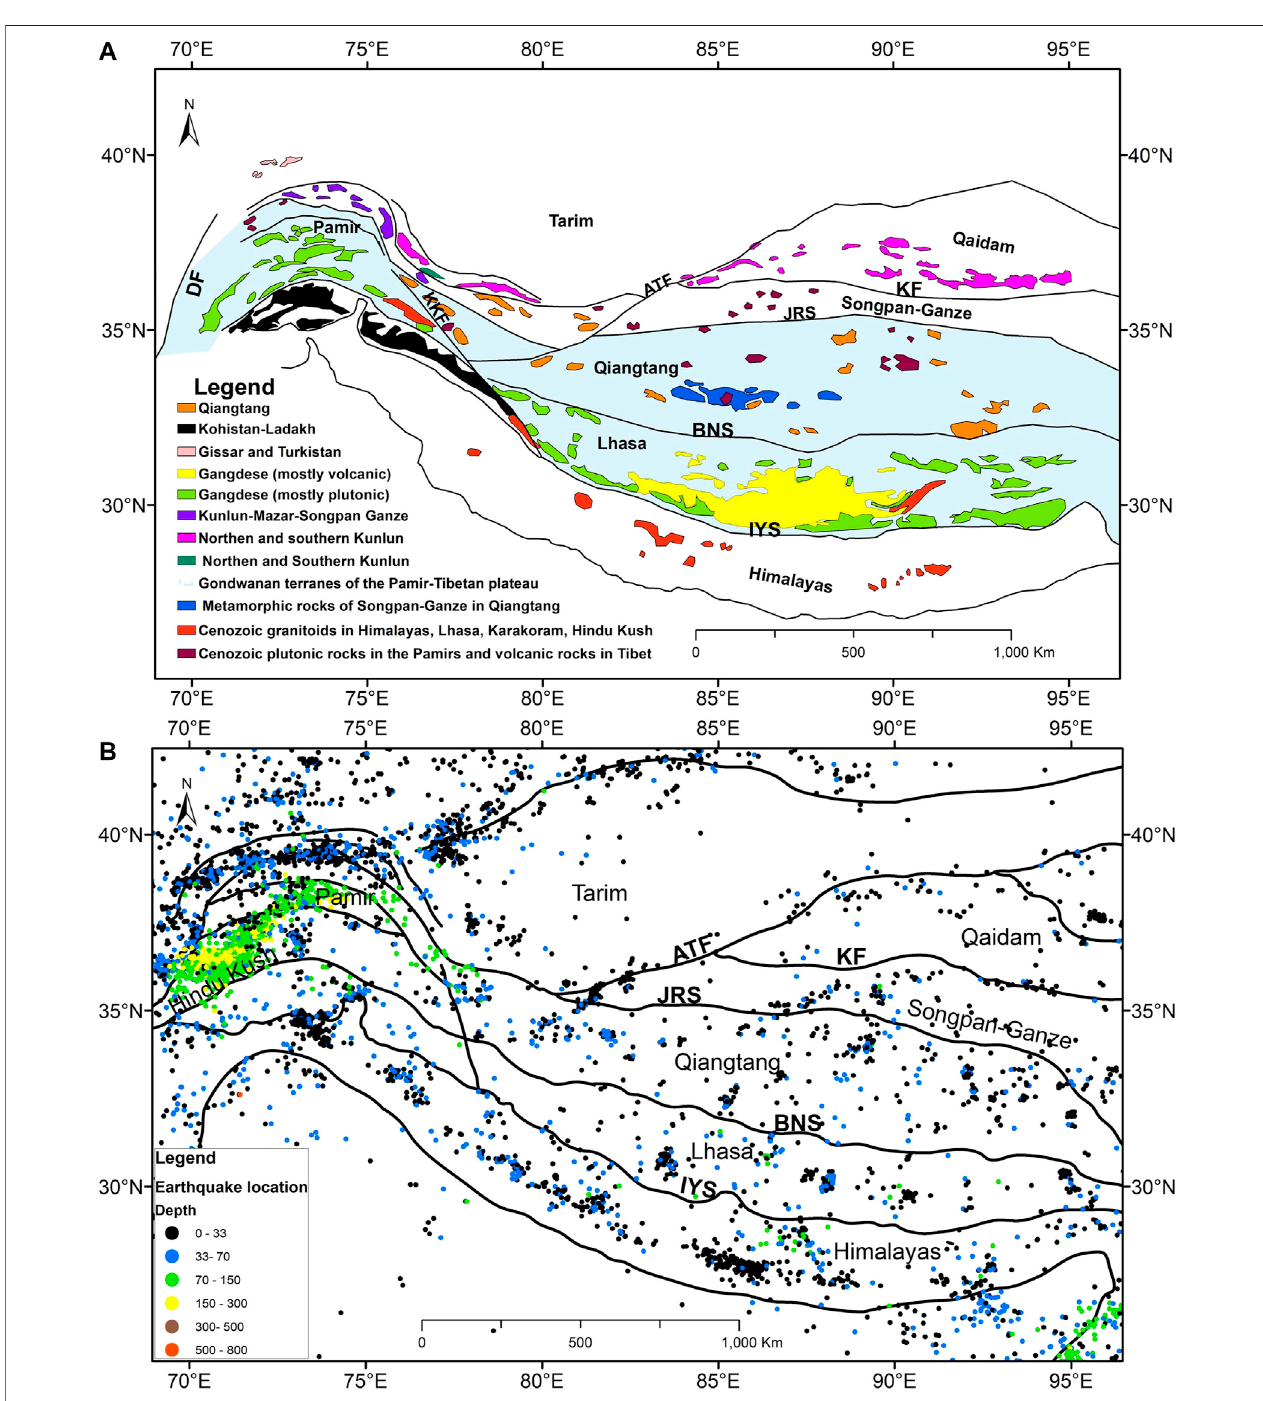
FIGURE2|(A) GeologicalmapshowingthelocationofmagmaticrocksbeneaththePamir – Tibetanplateaumodi fi edafterSchwabetal.(2004). (B) Mapofshallow and intermediate-depth earthquakes beneath the Pamir – Tibetan plateau from time period of 1990 – 2022 with magnitude > 4.5 obtained from Incorporated Research Institutions for Seismology (https://www.iris.edu/hq/).